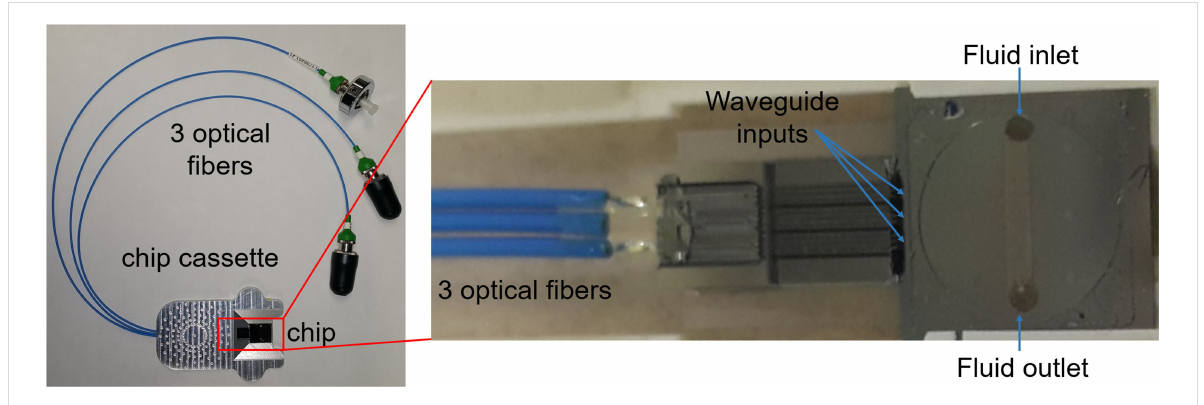
Figure 1: Optofluidic chip is secured in a chip cassette and is permanently bonded to three optical fibers, which deliver laser light to the three wave- guides on the chip surface. The chip also has a microfluidic channel with inlet and outlet holes.